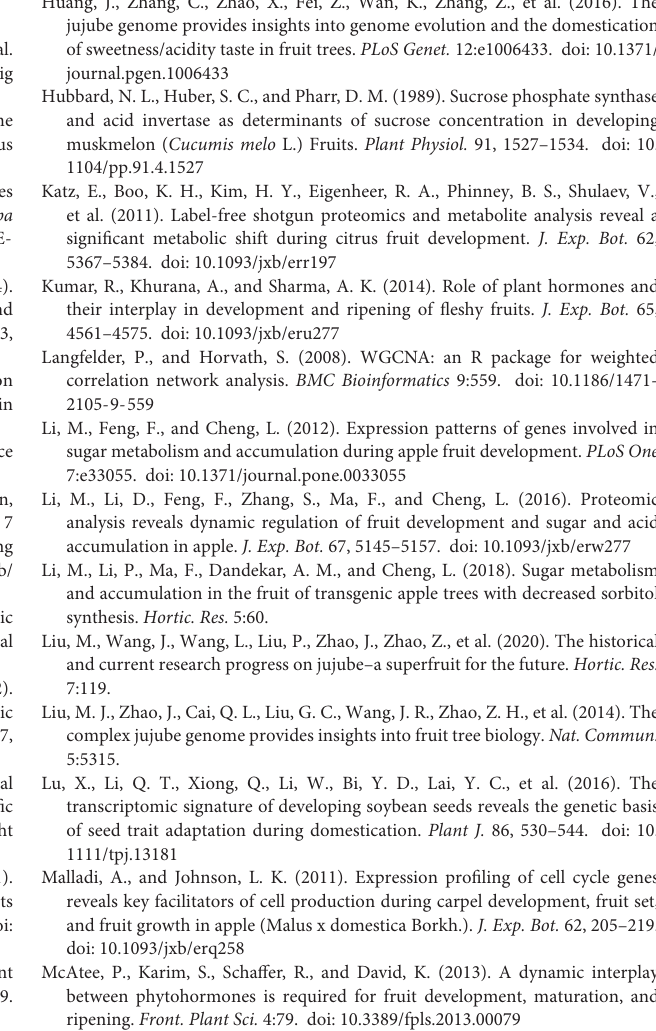
Supplementary Table 2 | Hub proteins with high connectivity in the WGCNA